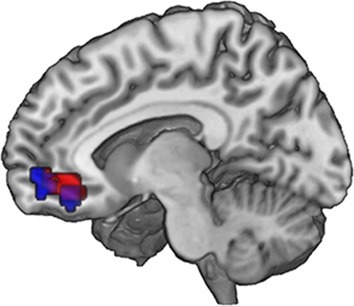
Neural correlates of subjective valuation: In the ventromedial prefrontal cortex, overlapping voxels correlate with WTP across all pictures (GLM 2, red) and with the WTP difference (increment value) when evaluating an FT image (GLM 3, blue). Data are shown using MRIcroGL (MNI template) and in radiological convention.